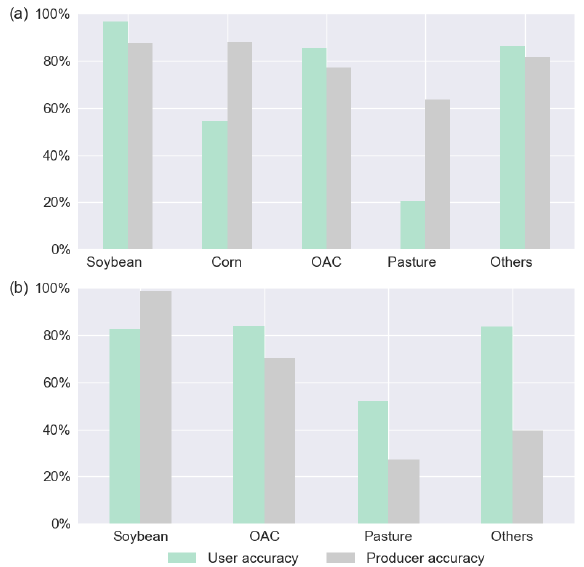
Figure 5. User (UA) and Producer (PA) accuracy for the best scenario results: (a) LEM: 03-15-2018 (scenario 12 BP); (b) Campo Verde: 03-09-2016 (scenario 10 BP).